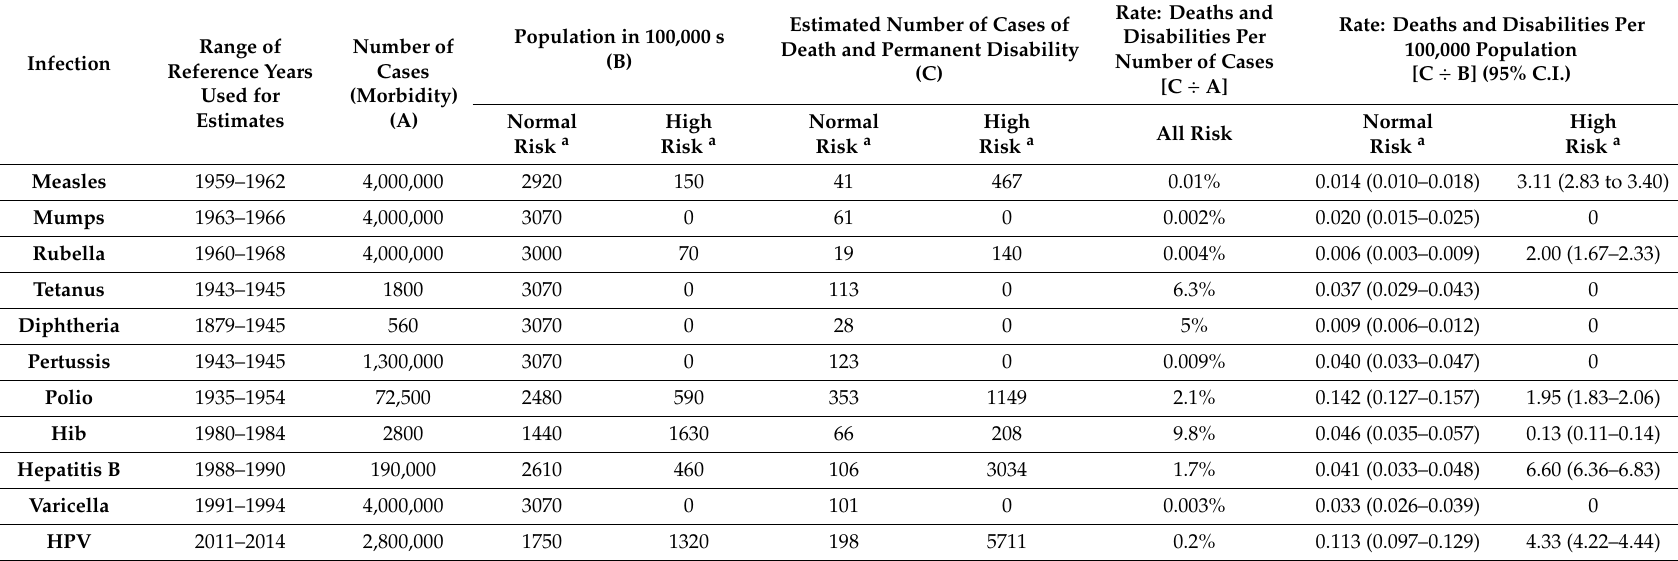
Table 1. Estimated rates of death and permanent disability from various infectious diseases in the USA in the absence of mass vaccination among normal and high risk individuals < 80 years of age,